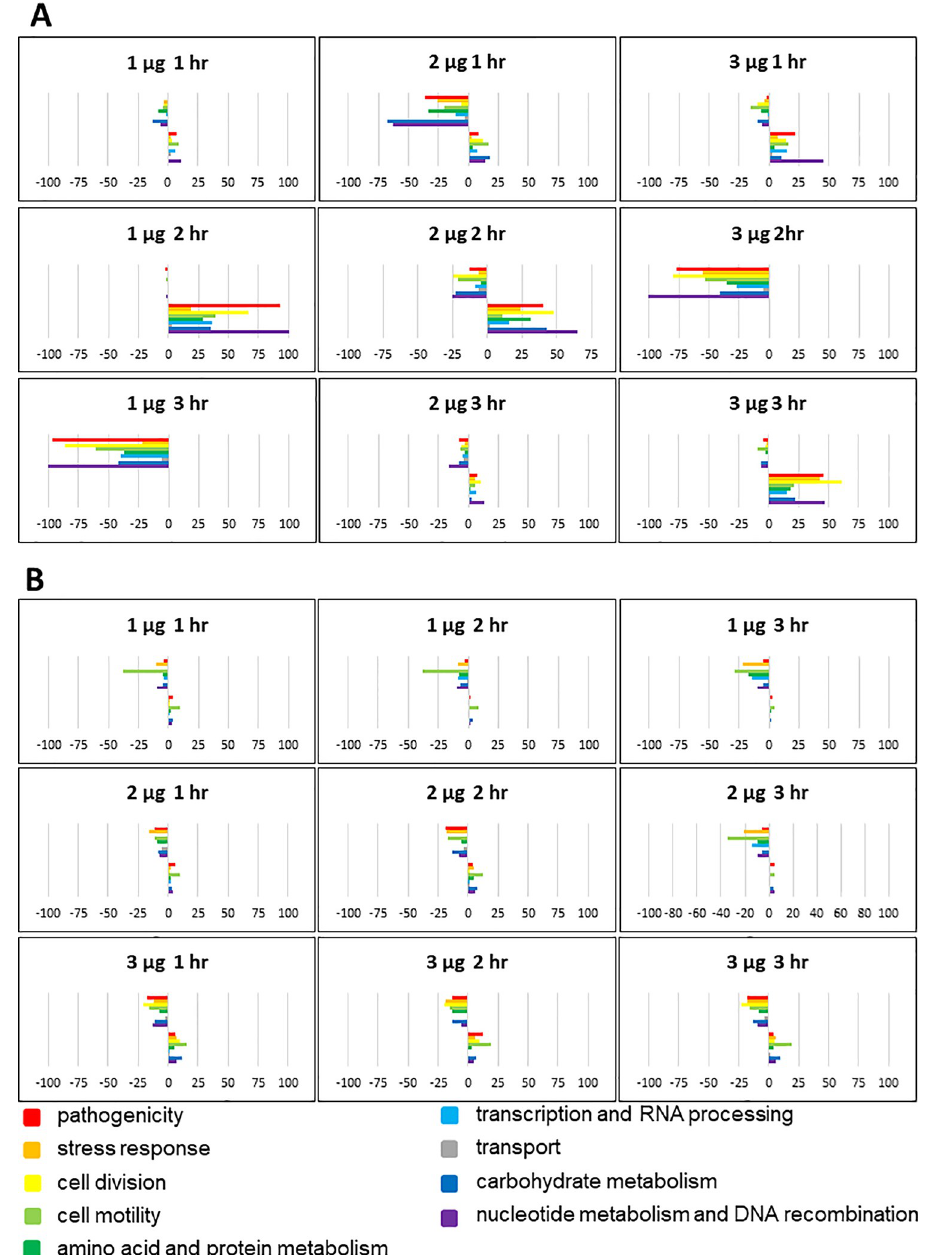
Fig 3. Functional categories of genes in E . coli O157:H7 (A) and L . monocytogenes (B) that were differentially expressed at different durations of exposure (1 hr, 2 hr, 3 hr) to O 3 . Colored bars represent the numbers of differentially expressed genes assigned to each functional category. Positive bars denote the number of upregulated genes. Negative bars denote the number of downregulated genes. Genes assigned to ‘other category’ and ‘unknown’ are not included in this